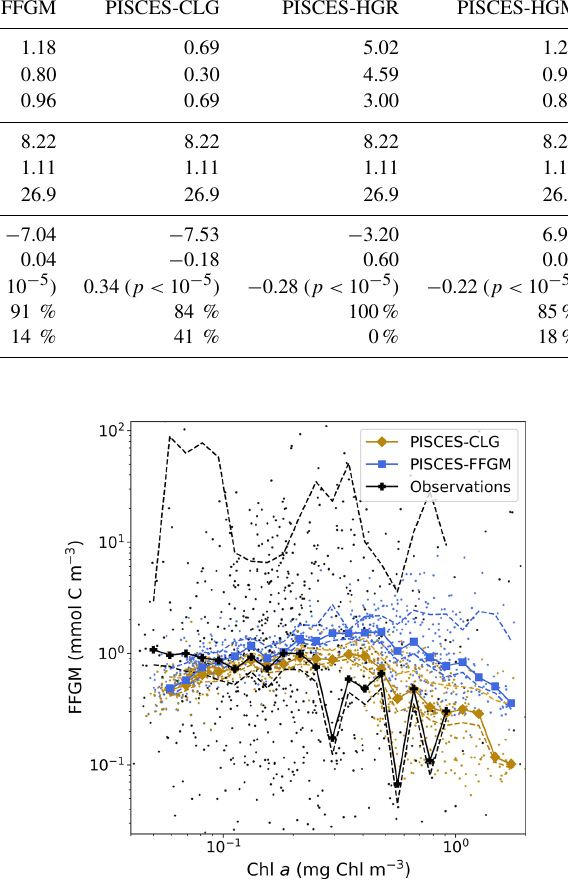
Figure 5. Chlorophyll–FFGM relationship. Log–log scatter plot showing FFGM concentration versus total chlorophyll concentra- tion for PISCES-FFGM, PISCES-CLG clogging run, and the At- lantECO vs. OC-CCI chlorophyll datasets. The datasets were grid- ded into an annual climatology with a spatial resolution of 5 ◦ . Each small dot corresponds to one grid cell of these climatologies. Large dots connected by a line represent the median per 0.07-wide log bins of chlorophyll; dashed lines represent standard deviations be- low and above the median for each